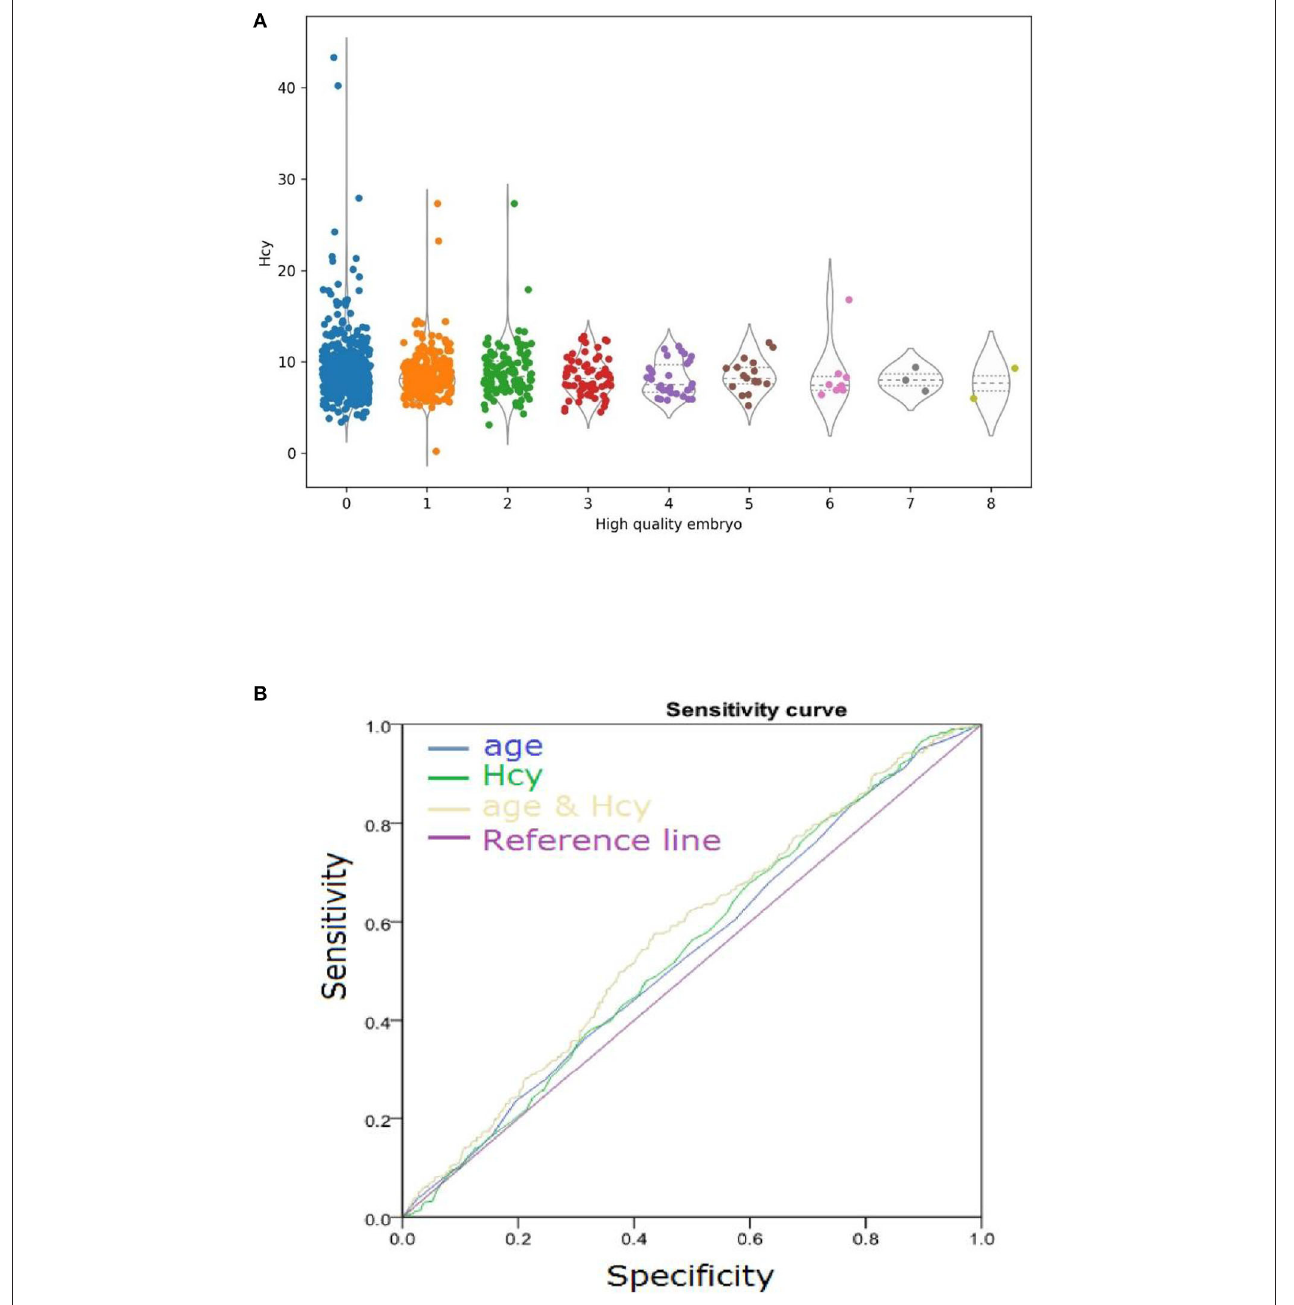
FIGURE 3 | (A) Serum Hcy levels negatively correlated with high-quality embryo number. Horizontal lines represent the median and interquartile range (IQR) of the data. (B) Diagnostic Performance of embryo quality. Comparison of model performance for predicting embryo quality using variables age and Hcy independently and using variables age and Hcy